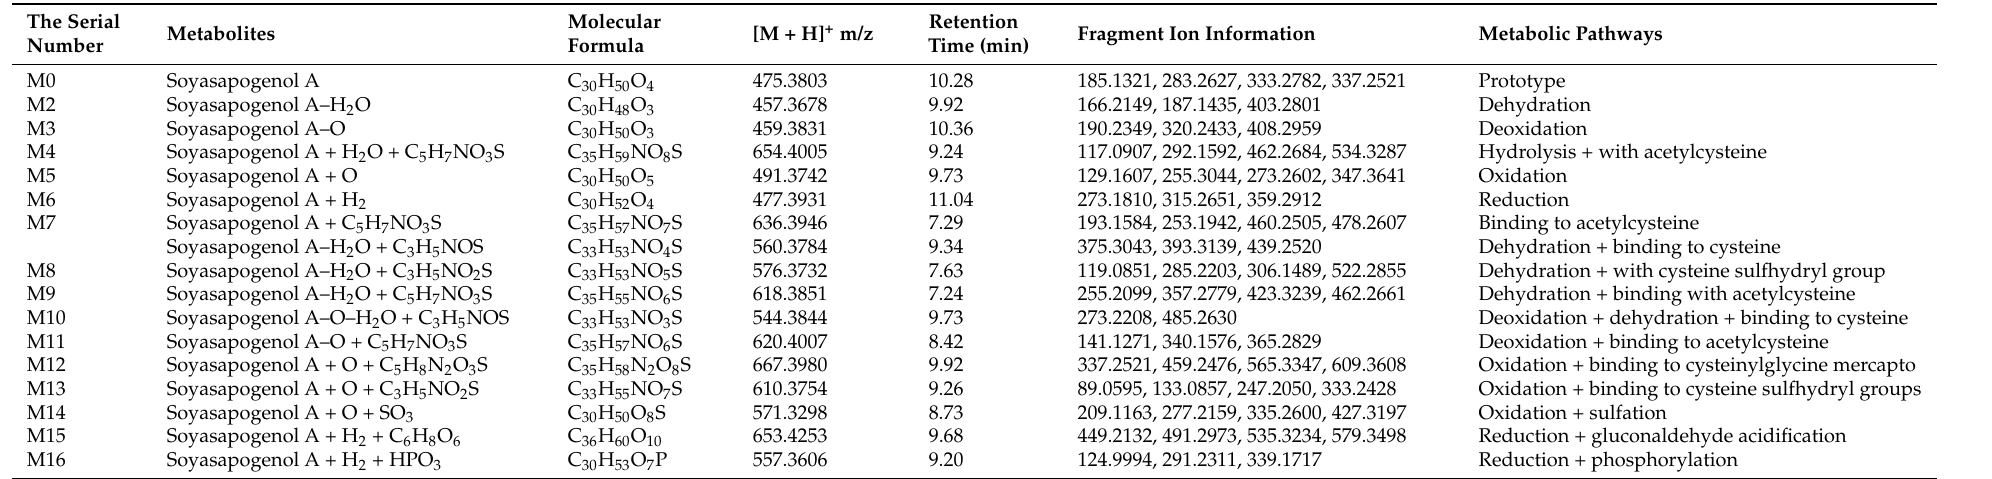
Table 3. Summary of the Mass Spectral Data of Soyasapogenol A and Its Metabolites Detected in Rat